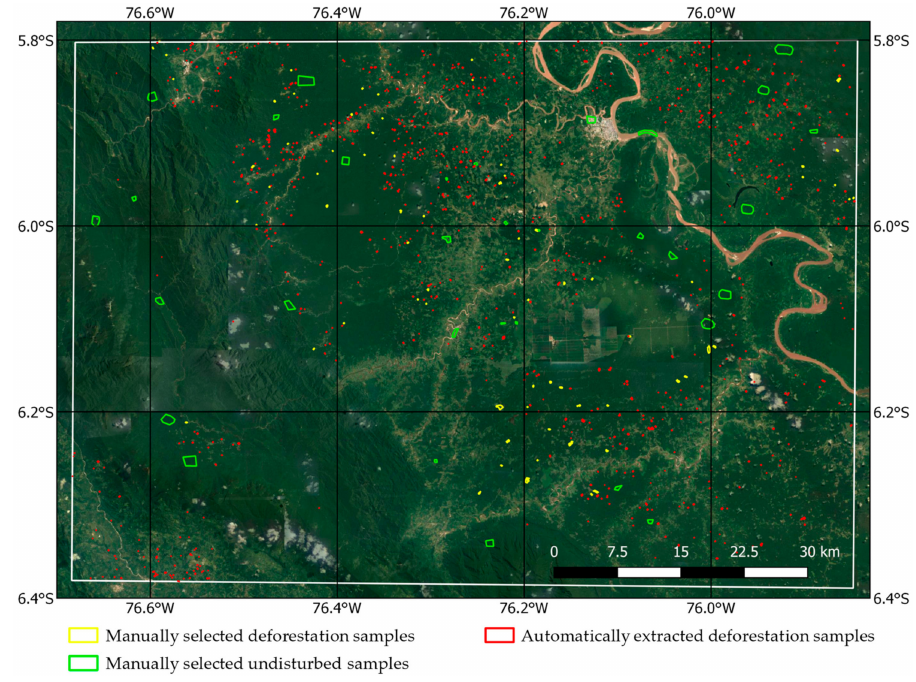
Figure 2. Location of the reference samples: manually selected deforestation (yellow) and undisturbed (green) samples, and automatically extracted deforestation samples (red). Optical background image from Google Earth (© 2018 Google). Table 1. Numbers and sizes of the reference samples constituting the validation database for deforestation